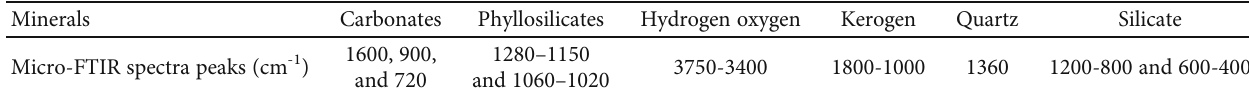
Table 2: Micro-FTIR spectra peaks of speci fi c minerals.